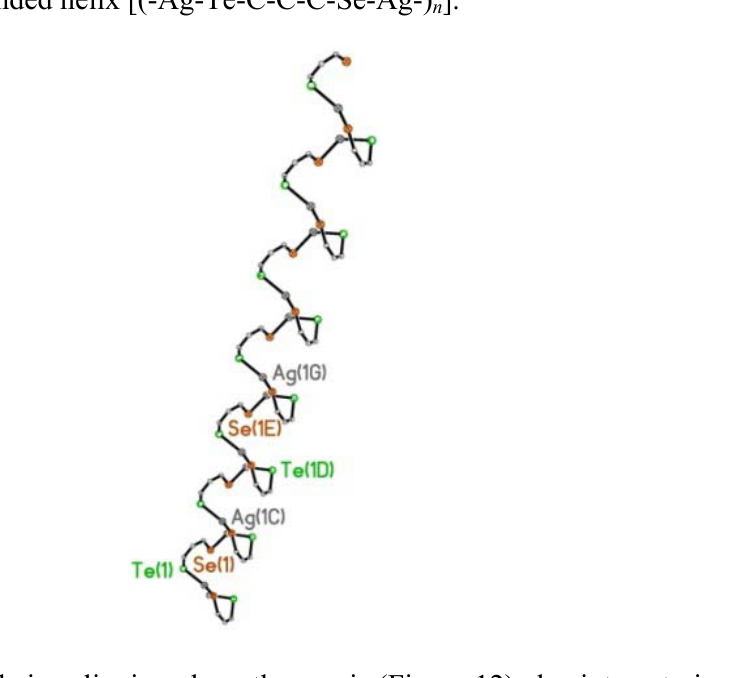
Figure 11. Silver(I) ions interconnect via Te-C-C-C-Se bridges from independent L3 ligands to form a left-handed helix [(-Ag-Te-C-C-C-Se-Ag-)